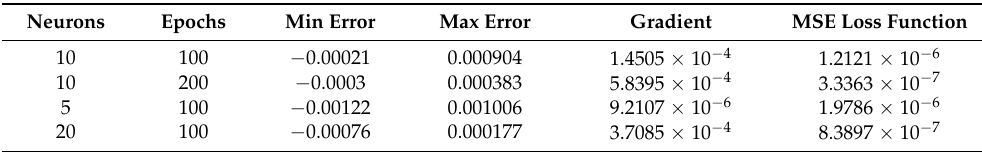
Table 2. Neural network analysis with different conditions. MSE loss function is calculated with the test dataset.